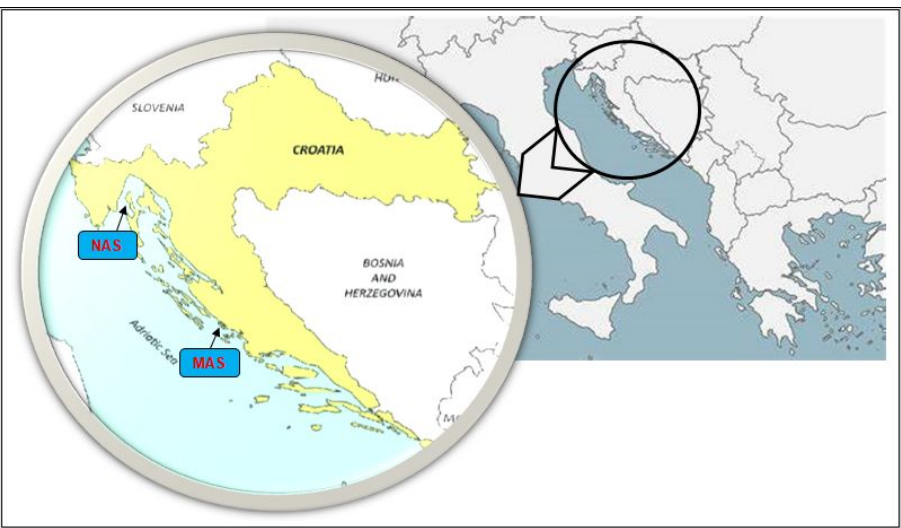
Figure 1. Sampling locations: NAS—marine fish farm in the north Adriatic and MAS—marine fish farm in the middle Adriatic.